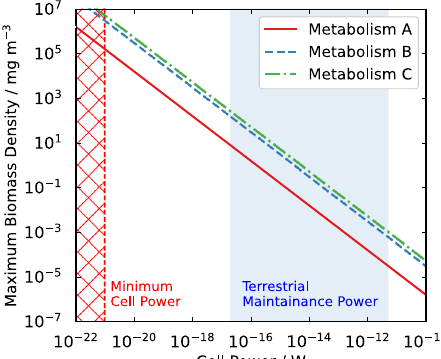
Fig. 4 Maximum biomass density as a function of cell-power requirement in the Venusian atmosphere. Biomass density in the cloud layer for metabolisms A, B, and C, as a function of cell power. The red dashed line indicates the estimated minimum limit on cell power for terrestrial microorganisms 44 and the red hatch region is the excluded region of the parameter space. The blue shaded region indicates the range of usual cell maintenance power requirements, measured in a laboratory setting, for terrestrial microorganisms 22